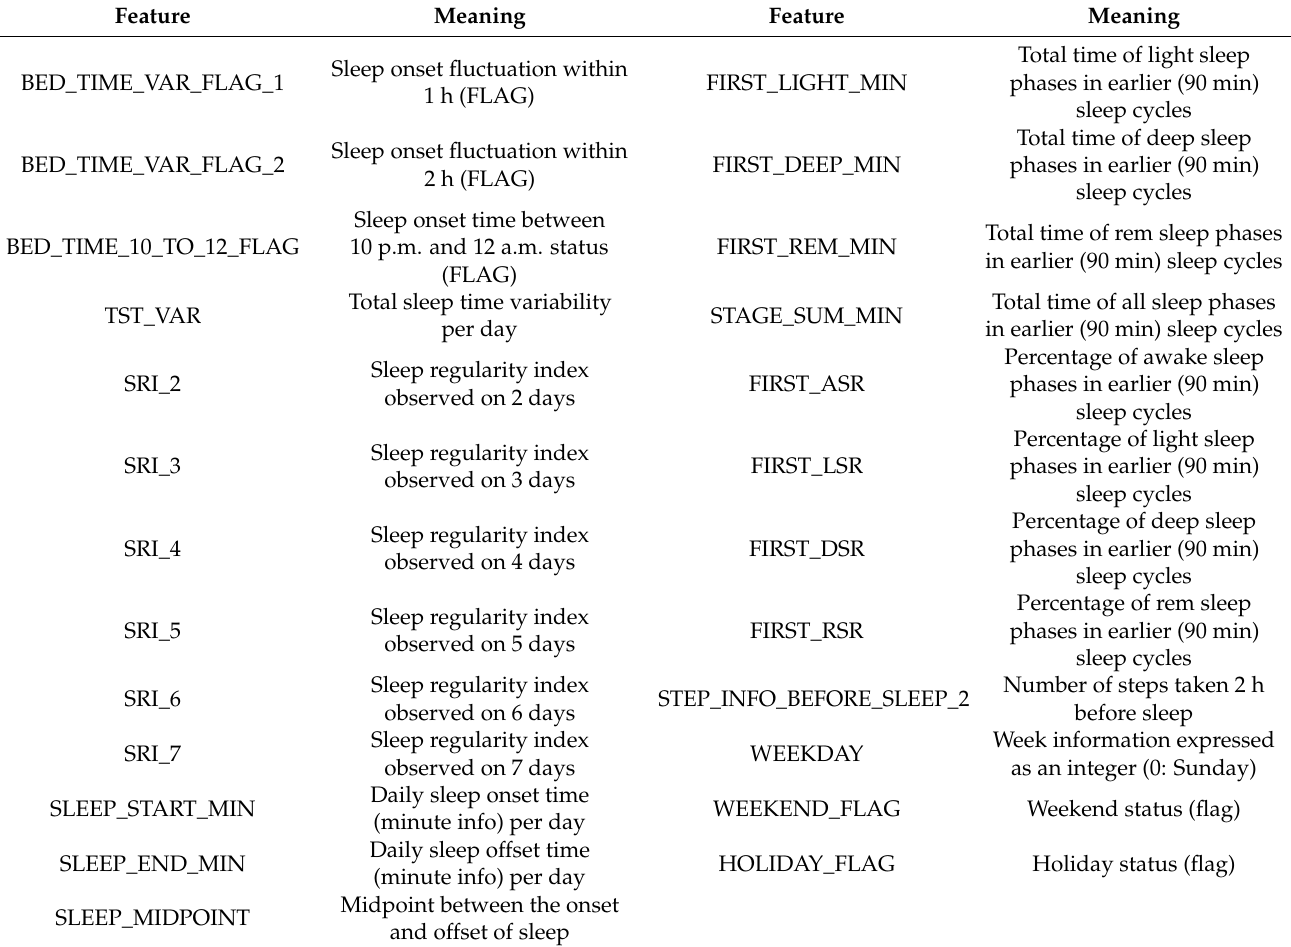
Table A1. Feature names and descriptions as generated from raw data collected daily/per